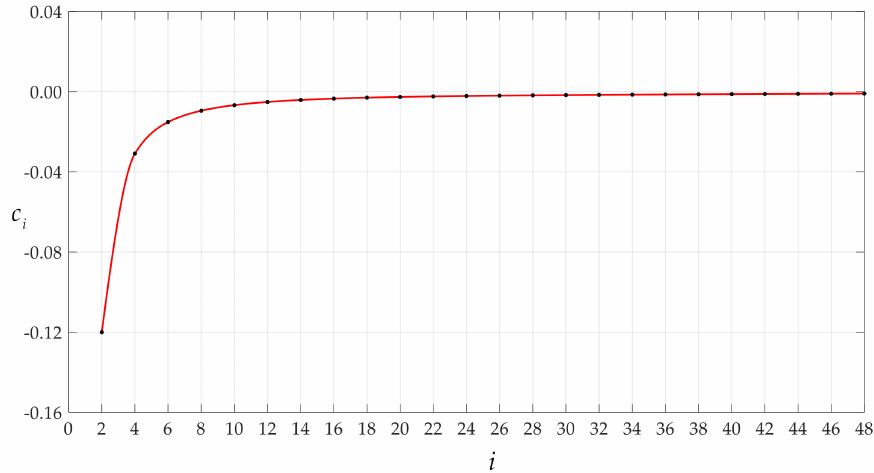
Figure 13. Variations of c i with i when q takes 0.0105 MPa.